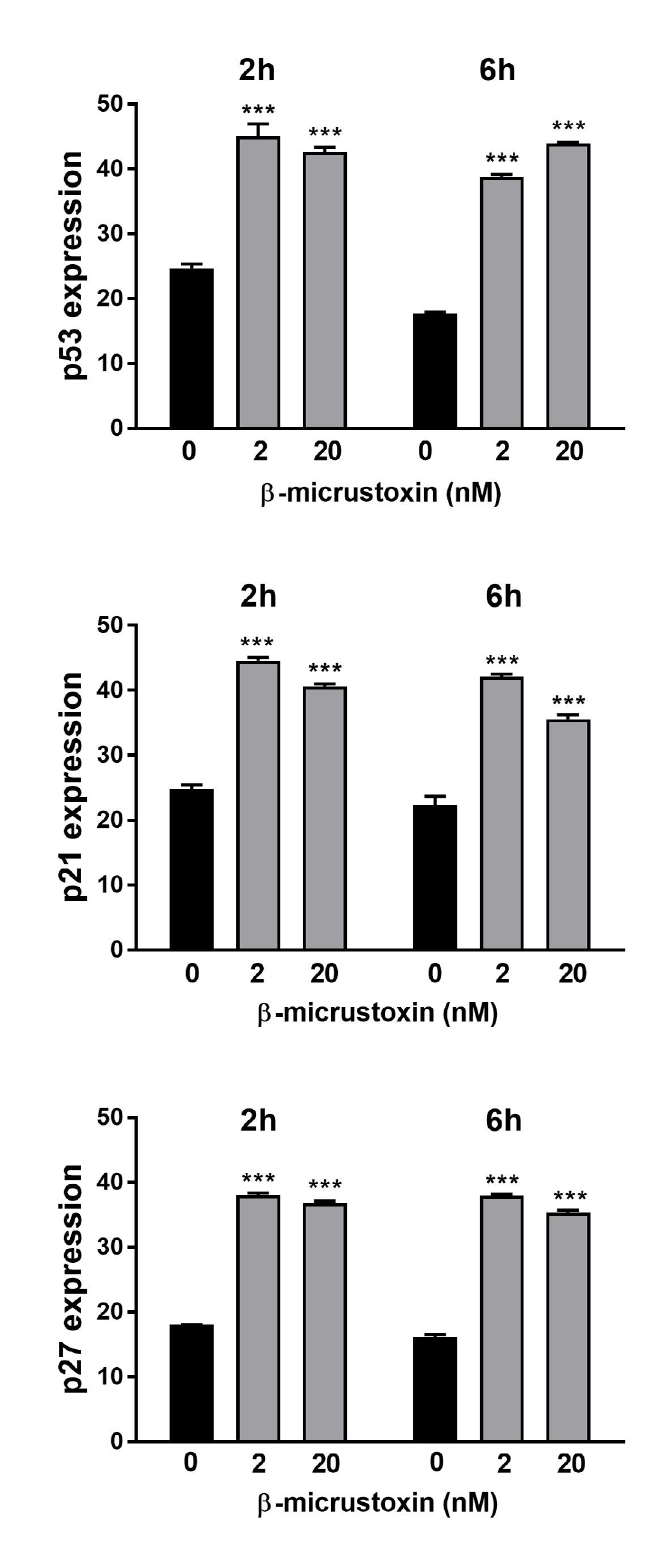
Figure 8. P53, p21 and p27 regulatory proteins expression in cultured astrocytes. Proteins were evaluated after incubation of astrocytes in the absence (control) or presence of β-micrustoxin (2, 20 nM) for 2 h or 6 h, by flow cytometry. Two-way ANOVA: p < 0.001; Bonferroni post-hoc test: ***p < 0.001 in relation to the respective control, N =